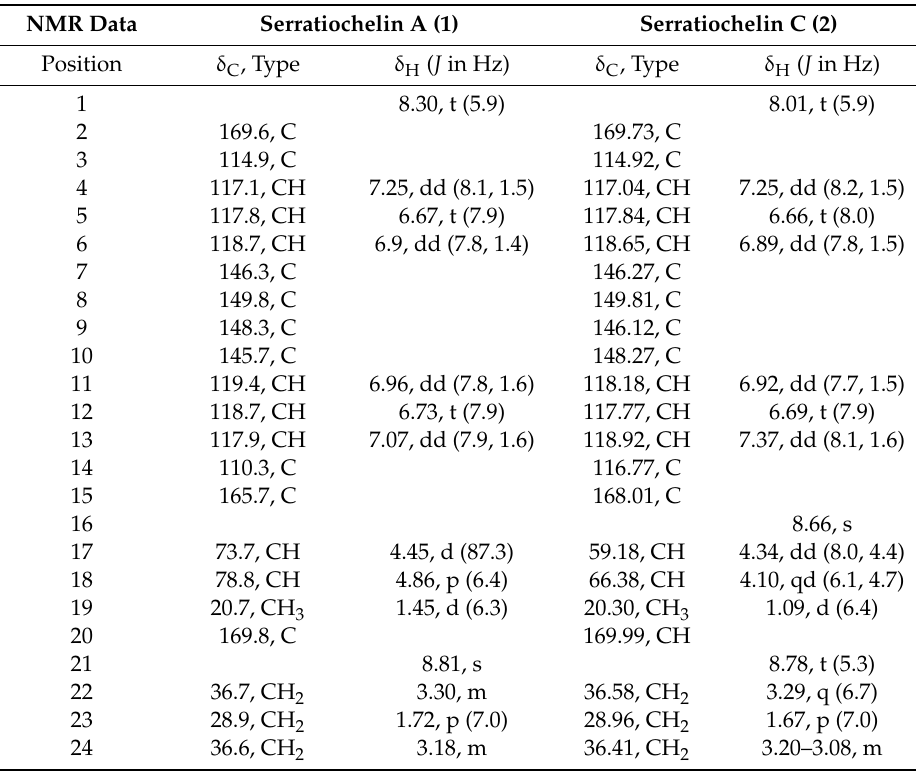
Table 1. 1 H- and 13 C-NMR data for serratiochelin A ( 1 ) and C ( 2 ) in DMSO- d 6 .